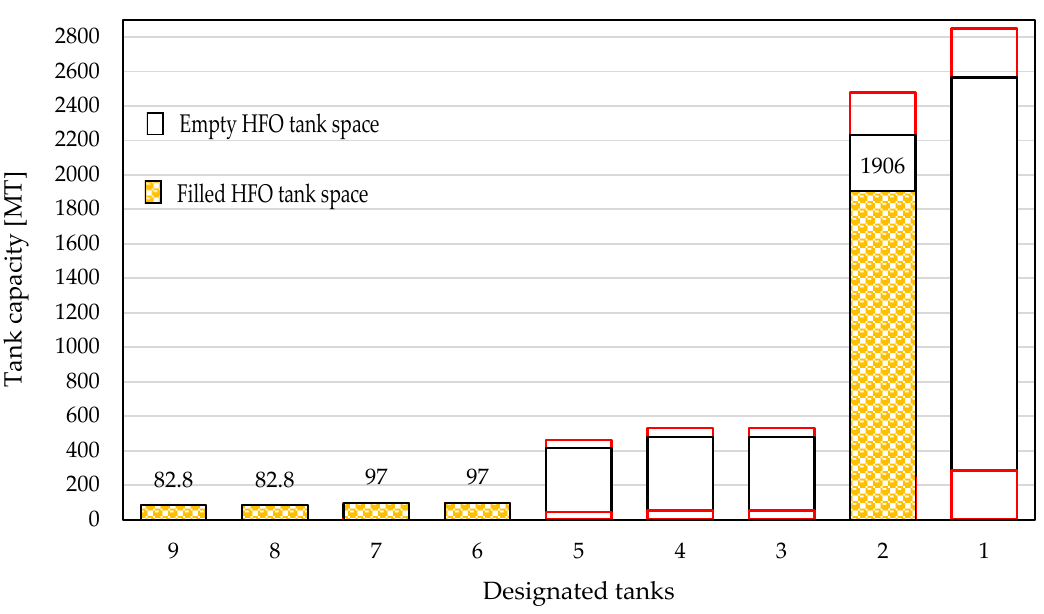
Figure 6. HFO bunker condition before bunker loading for the second example. The third example illustrates a situation when the proposed mathematical model does not allow for maximization of the total quantities, because the calculated old fuel quantity is in the interval between 10% and 90% of tank capacity. In this case, the quantity of the old fuel is 5110.6 MT, located as follows: the service tanks contain 82.8 MT, both se tt ling tanks full (97 MT), LHSFO 400 MT, HFO aft port 531 MT, HFO aft starboard 0 MT,